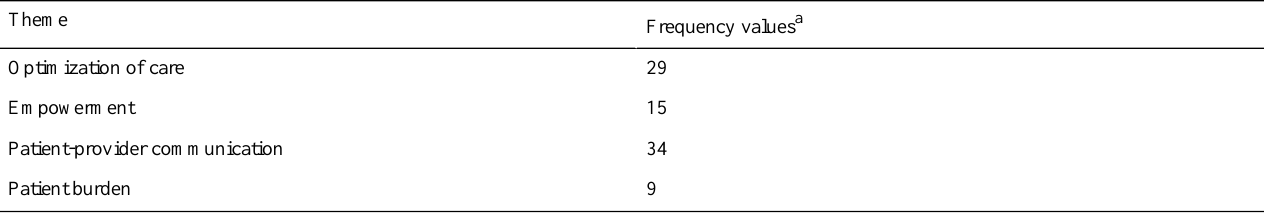
Table 2. Frequency of identified themes in 8 focus